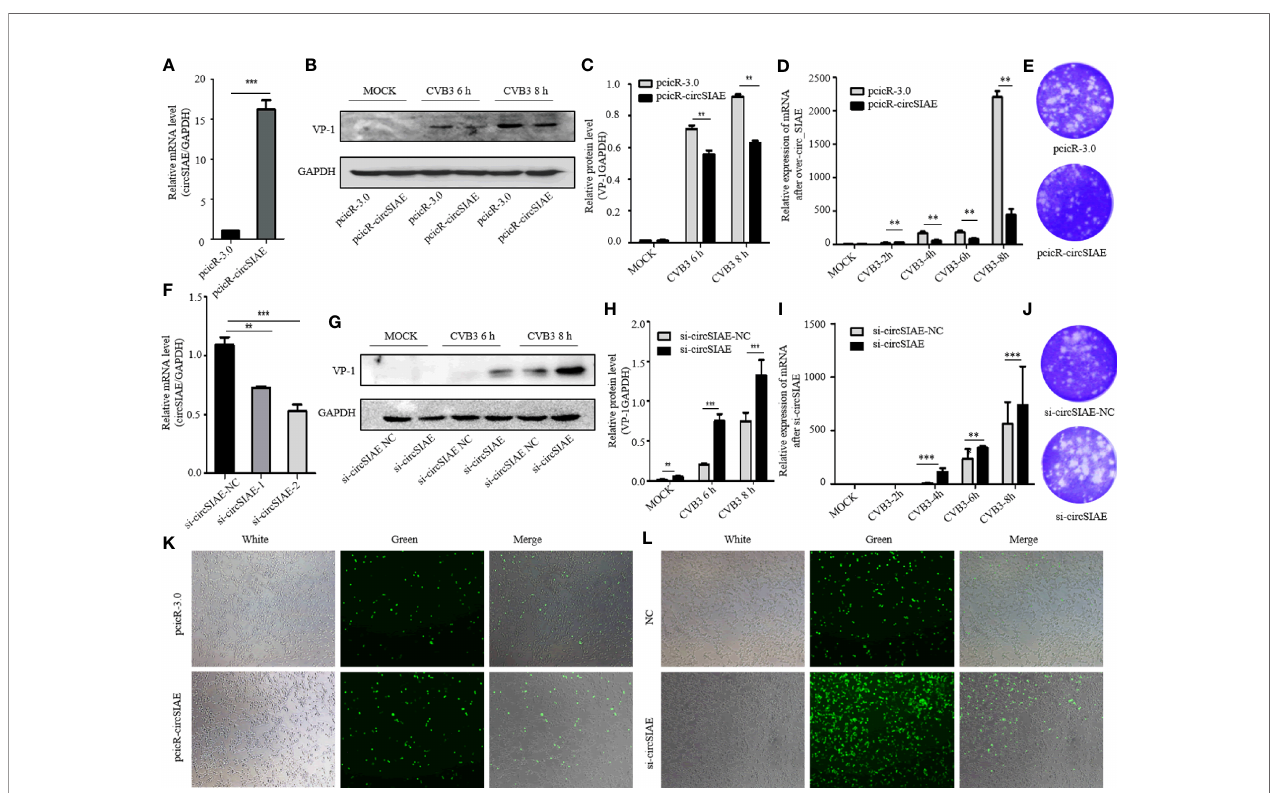
FIGURE 2 | The effect of circSIAE on CVB3 replication. (A) After transfection of no-load pcicR-3.0 and overexpression of pcicR-circSIAE in HeLa, total RNA was extracted 36 h post-transfection, and the success of overexpression of circSIAE was veri fi ed by qRT-PCR. (B) After 36 hours post-transfection with pcicR-3.0 and pcicR-circSIAE, HeLa cells were infected with CVB3 (multiplicity of infection = 5), and total protein was extracted at 6 and 8 h post-infection. The expression of VP- 1was detected by Western blot. (C, H) Protein levels of VP-1 were quanti fi ed by densitometric analysis using ImageJ, normalized to GAPDH and presented as fold changes compared to the control group. (D) After 36 hours post-transfection with pcicR-3.0 and pcicR-circSIAE, HeLa cells were infected with CVB3 and total RNA was extracted at 2, 4, 6 and 8 h post-infection. The expression of VP-1 was detected by qRT-PCR. (E, J) To verify the effect of circSIAE on CVB3 proliferation, cells were infected with CVB3 36 hours post-transfection with no-load pcicR-3.0 and circSIAE (NC, si-circSIAE-2), and viral supernatant was collected at 6 hours post- infection for viral plaque tests. (F) The knockdown ef fi ciency of circSIAE was veri fi ed by qRT-PCR. (G) Cells were transfected with empty vector (NC) and si-circSIAE-2 and then infected withCVB3. Total protein was isolated at 6 and 8 h post-infection. Western blotting was used to analyze virus replication. (I) Cells were transfected with empty vector (NC) and si-circSIAE-2 and then infected withCVB3. Total RNA was isolated at 2, 4, 6 and 8 h post-infection. The expression of VP-1 was detected by qRT-PCR. (K, L) After 293T cells were co-transfected with CVB3-eGFP, pcicR-3.0/pcicR-circSIAE and NC/si-circSIAE-2, the fl uorescence of infected cells was observed by fl uorescence microscopy, and the effect of circSIAE on CVB3 replication was analyzed. **p < 0.01, ***p <